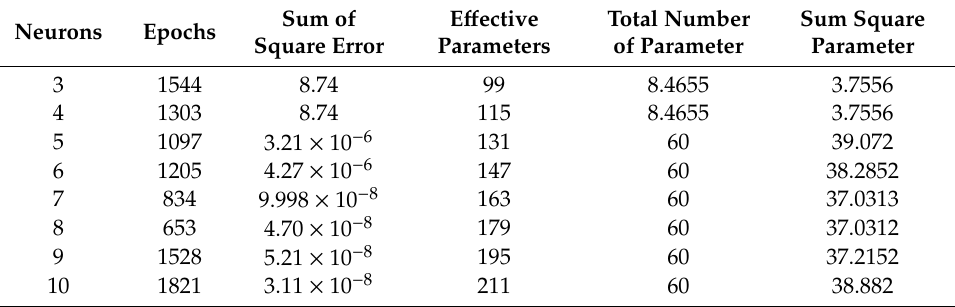
Table 11. Training result for hidden layer